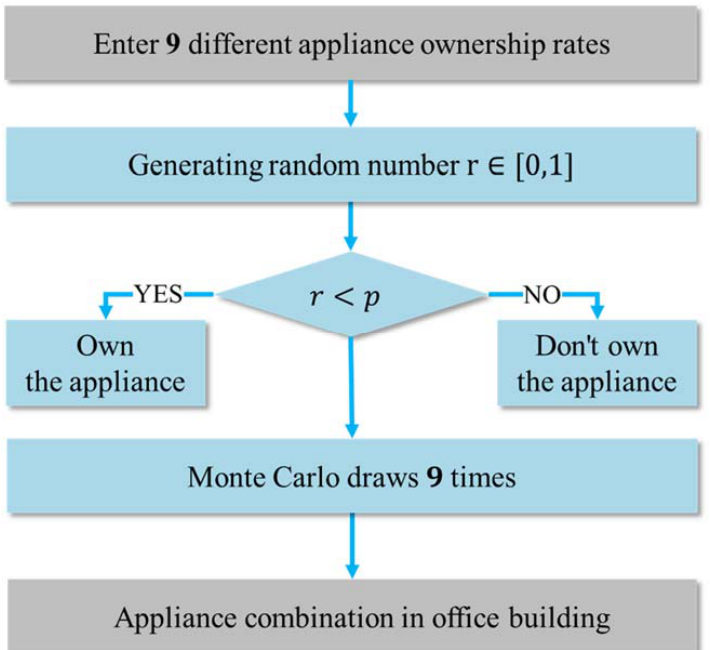
Figure 4. The algorithm flow of determining appliance combination in an office building.